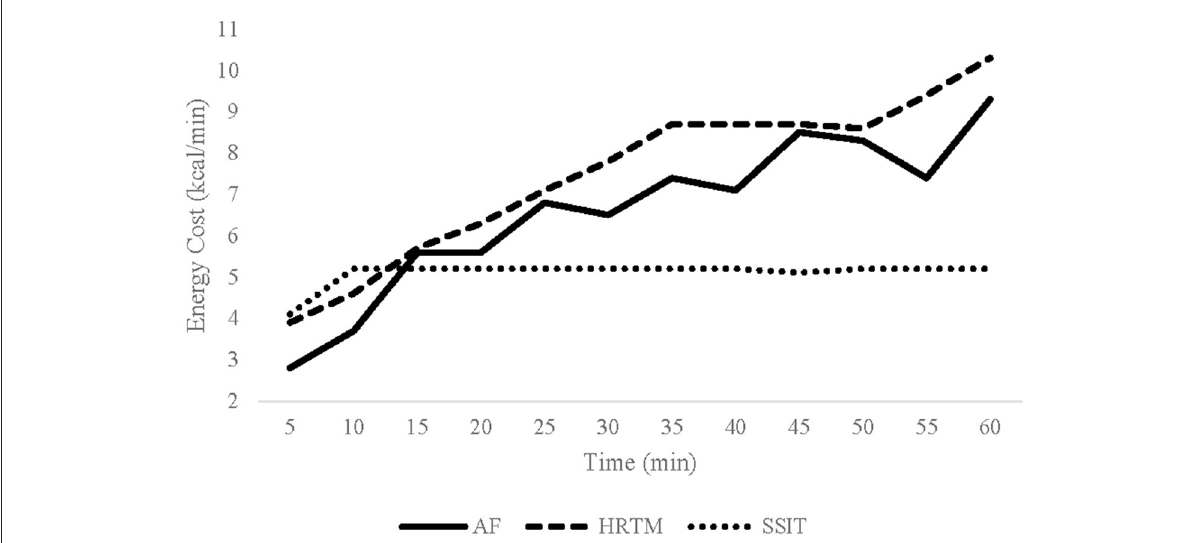
FIGURE1 Average Kcal/min across each condition (AF, HRTM, SSIT). AF, Animal Flow; HRTM, heart rate matched treadmill walking; SSIT, self-selected intensity treadmill walking.